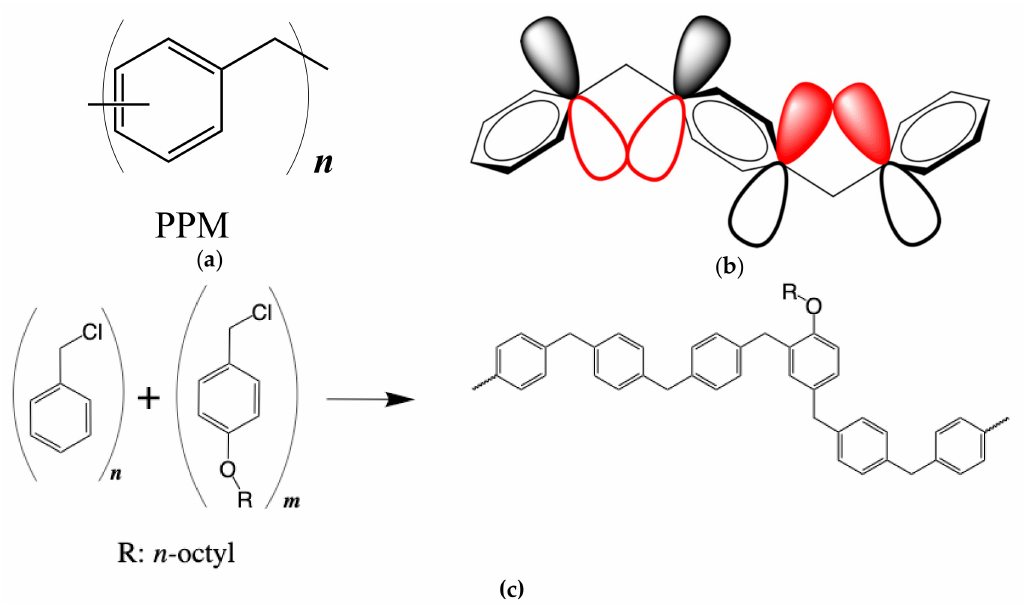
Figure 1. ( a ) Repeating units of poly(phenylene methylene) (PPM), ( b ) schematic representation of homoconjugation in PPM: p-orbitals of phenylene rings overlap even if they are electronically separated by methylene group, ( c ) scheme of the synthesis of random copolymers based on PPM obtained by mixing di ff erent fractions ( n and m , m / ( m + n ) = 5.3% mol / mol or 11.2% mol / mol) of benzyl chloride and its derivative (4-octyloxybenzyl chloride), and structure of a sequence of the resulting random